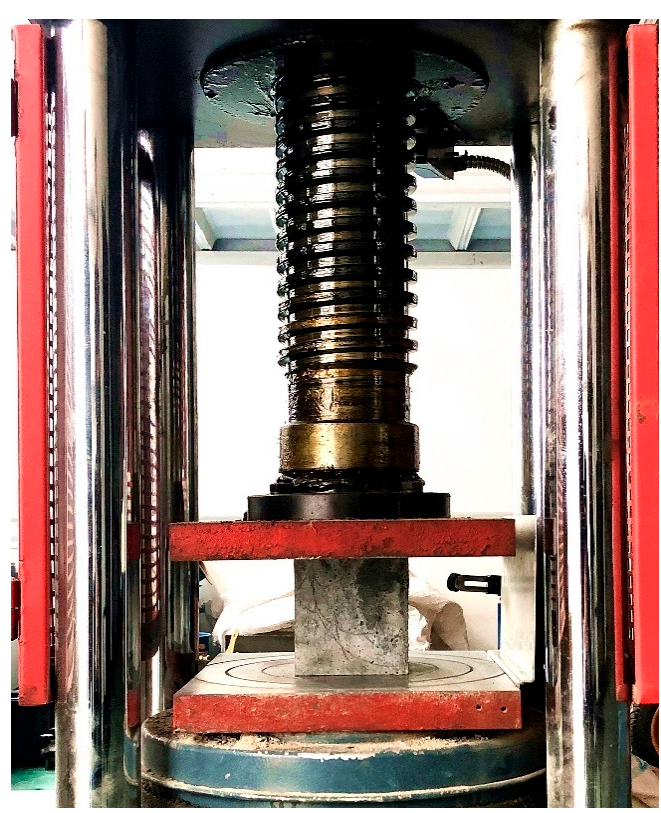
Figure 8. Cube compressive strength test.